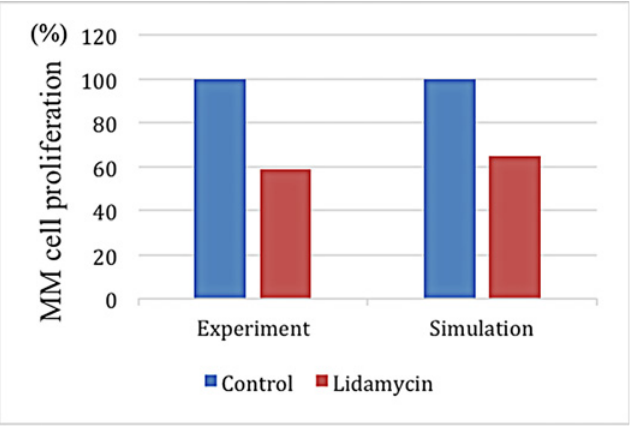
Fig 14. A comparison of the experimental and simulated data after Lidamycin